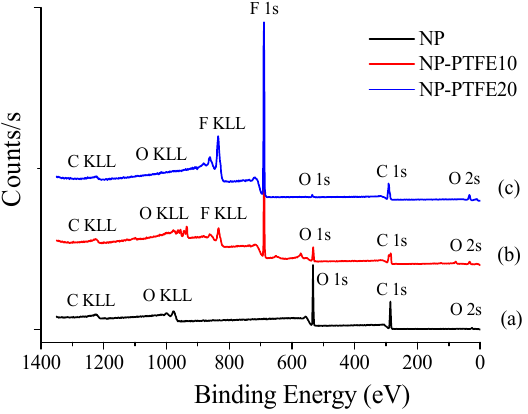
Figure 3. The X-ray photoelectron spectroscopy (XPS) spectra of the new pressboard ( a ), new pressboard surface as-prepared. PTFE film for 10 min ( b ) and 20 min ( c ).